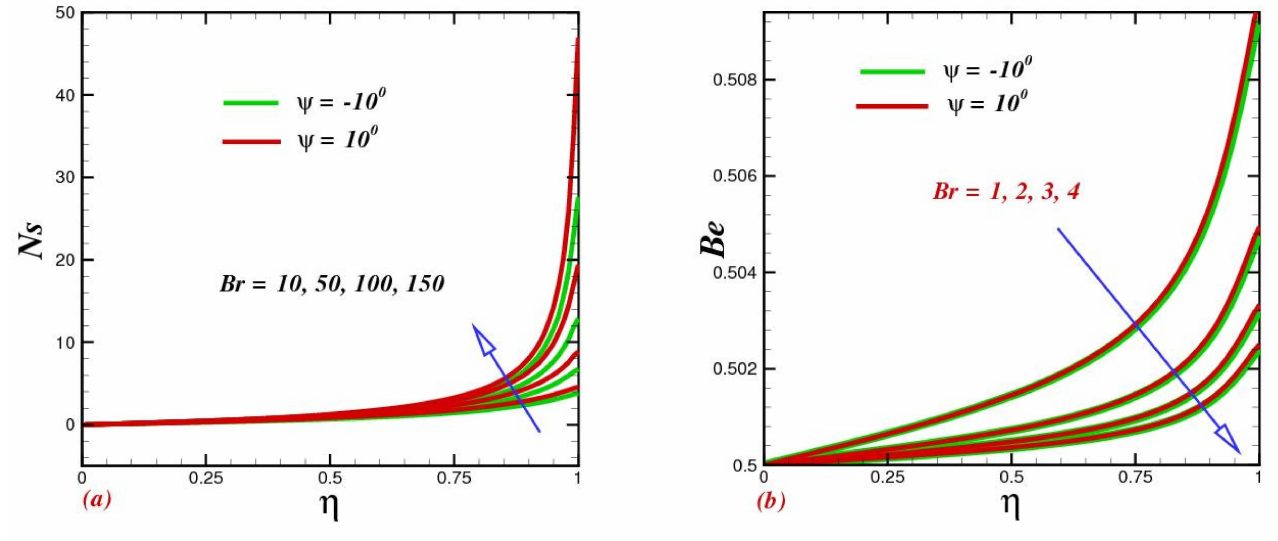
Figure 7. Impact of the Brinkmann number Br on ( a ) entropy production Ns and ( b ) the Bejan profile Be